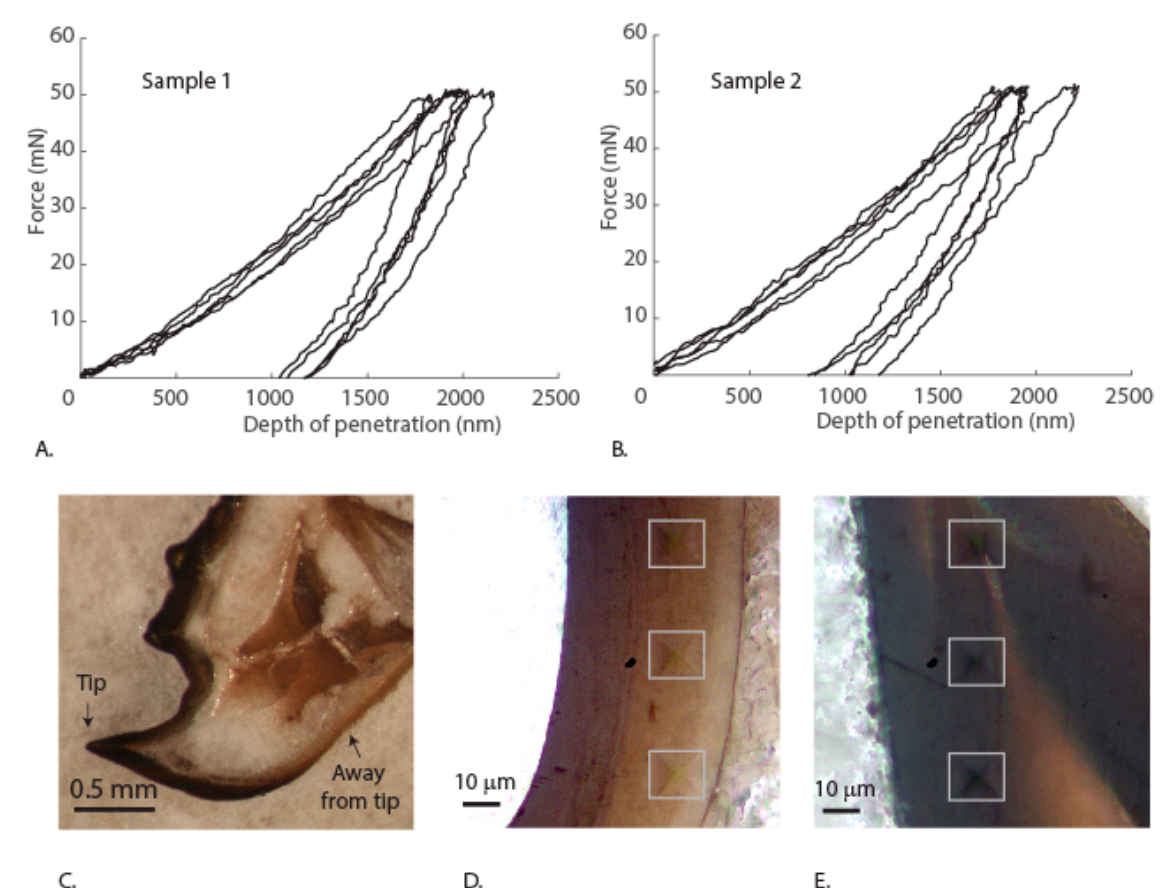
Figure 6. ( A , B ) Force depth curves of microindentation from sample 1 and sample 2. ( C ) Polished cross-section of the mandible. ( D ) Vickers indentation impressions in the “away from tip” region. ( E ) Vickers indentation impressions in the “away from tip” region.